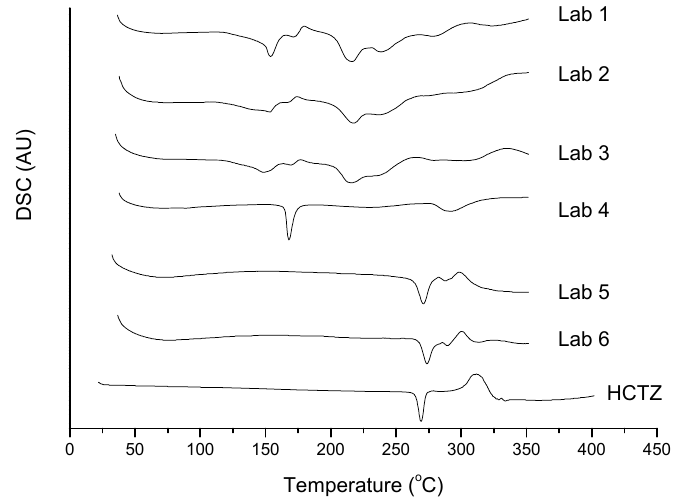
under nitrogen atmosphere and a heating rate of 10 °C·min − 1 .